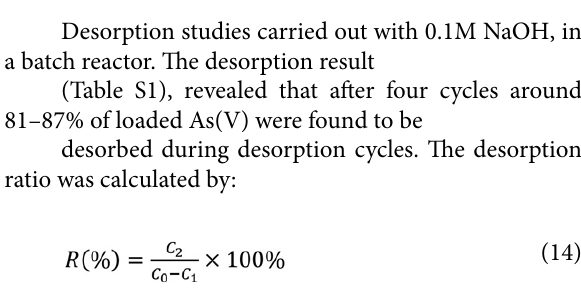
Van’t Hoff plot